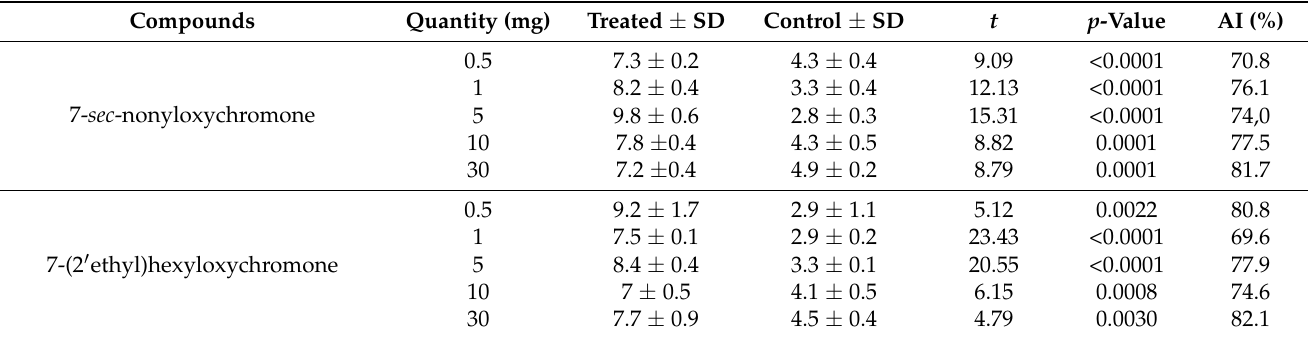
Table 19. T -test comparison of the average numbers of mosquitoes in the two zones: control and treated with 7- sec - nonyloxychromone ( 12 ) and 7-(2 (cid:48) -ethyl)hexyloxychromone ( 13 ). Compounds